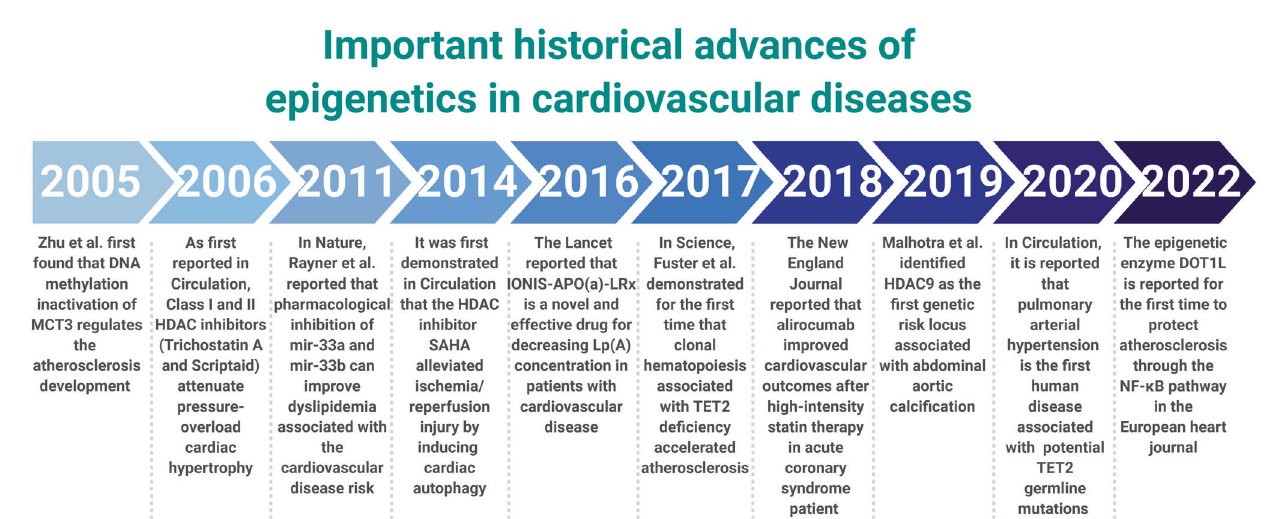
Fig. 4 Important historical advances of epigenetics in cardiovascular diseases. This fi gure was created with the aid of Biorender (https:// biorender.com/). MCT3 monocarboxylate transporter 3, HDAC histone deacetylase, SAHA suberoylanilide hydroxamic acid, Lp(A) lipoprotein